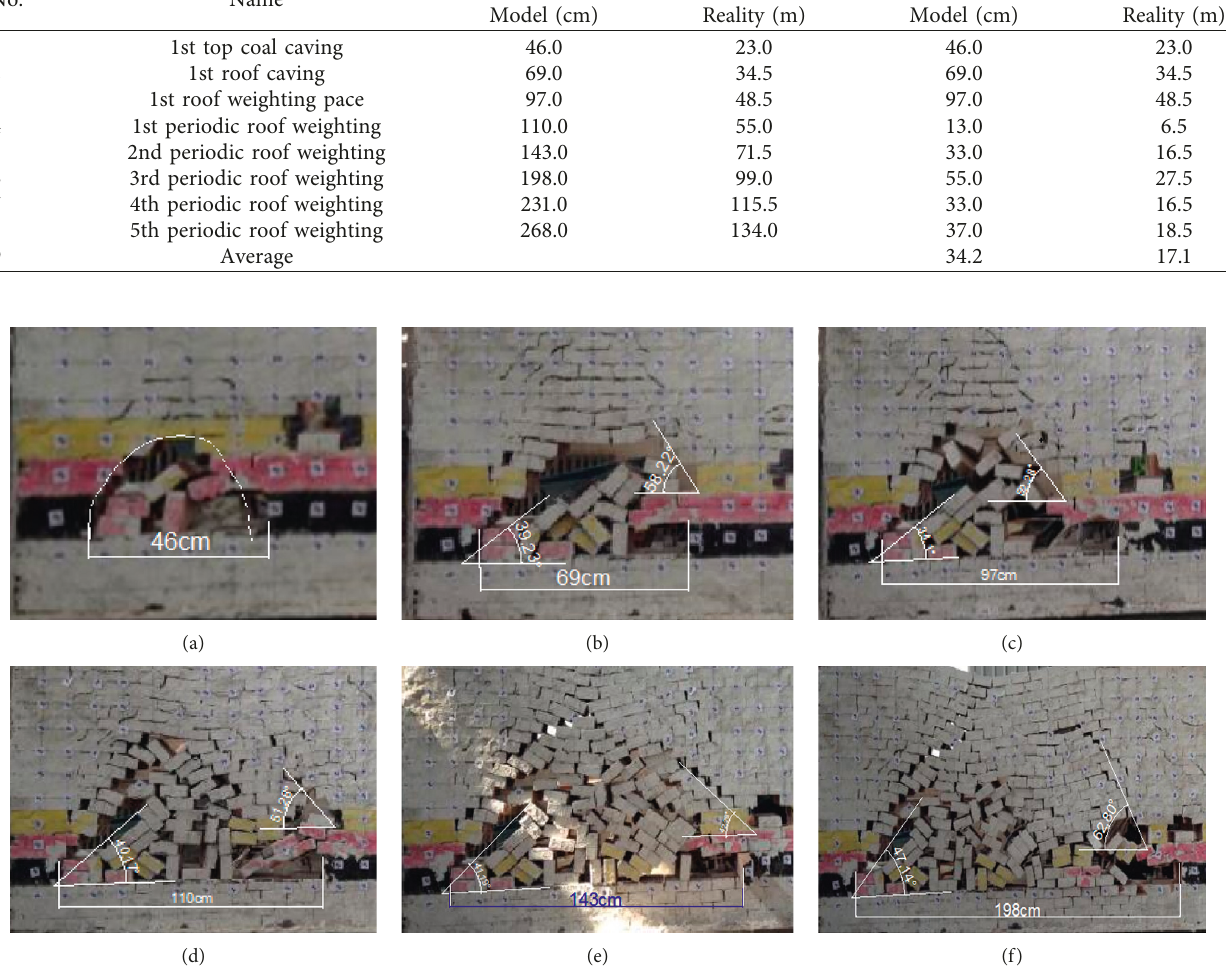
Figure 1: The advancing distance of working face and strata pressure phenomenon of stope in 10cm (5m) interlayer. (a) 1st top coal caving. Table 2: The statistics of top coal, immediate roof, and main roof collapsing interval of 80 cm (40 m) interlayer.